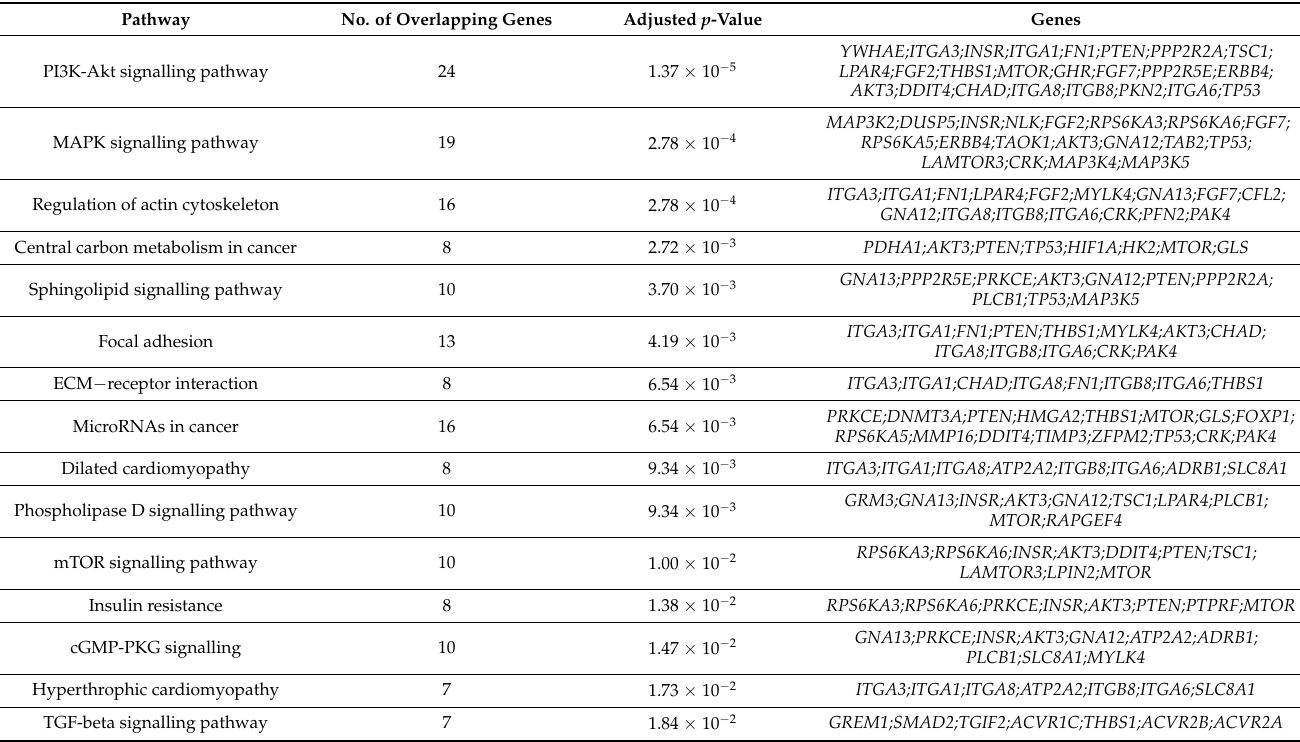
Table 4. KEGG pathway analysis of miR-199a-3p and miR-151a-3p targets. The FDR-adjusted p